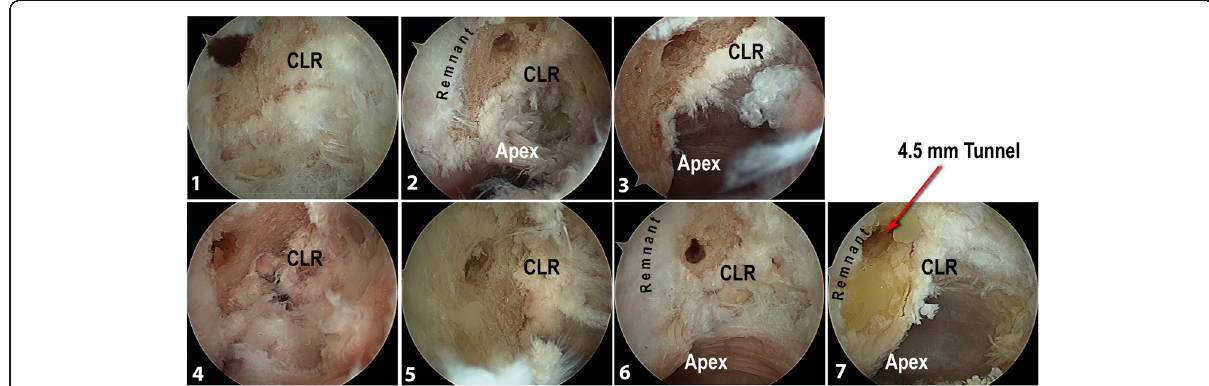
Fig. 4 Arthroscopic views (through an anterolateral approach of the right knees) of the medial part of the lateral femoral condyle with tunnel center location on the seven